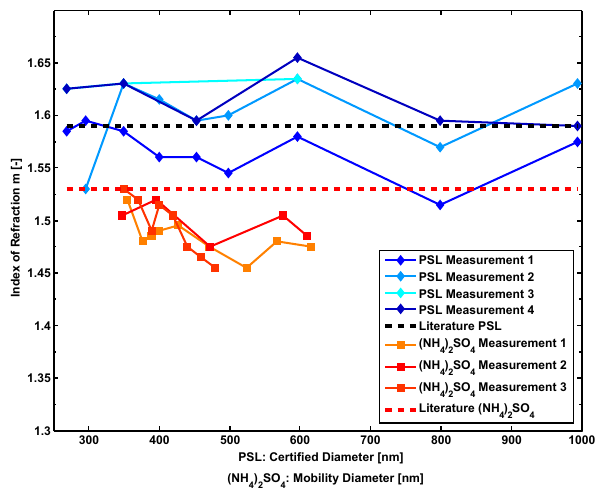
Figure 10. Retrieved refractive indices for dry, nebulized ammo- nium sulfate, ( NH 4 ) 2 SO 4 (reddish colors; plotted against mobility diameter) and different polystyrene latex spheres, PSL (bluish col- ors; plotted against certified diameter)